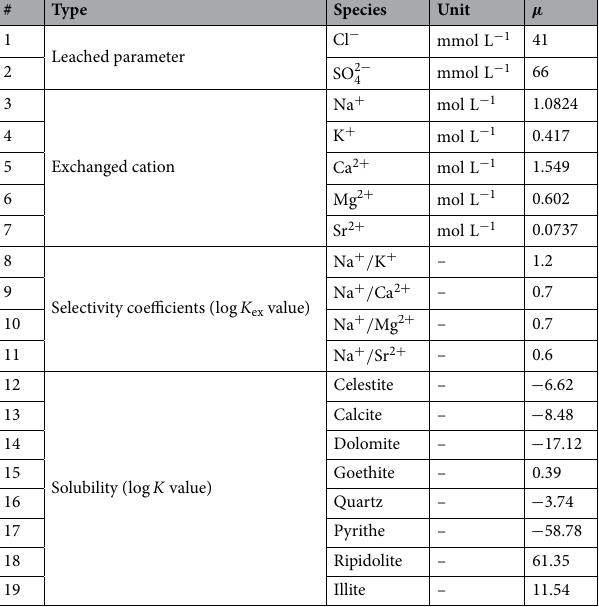
Table 1. List of the 19 uncertain input parameters with their reference values µ (unperturbed state of the geochemical